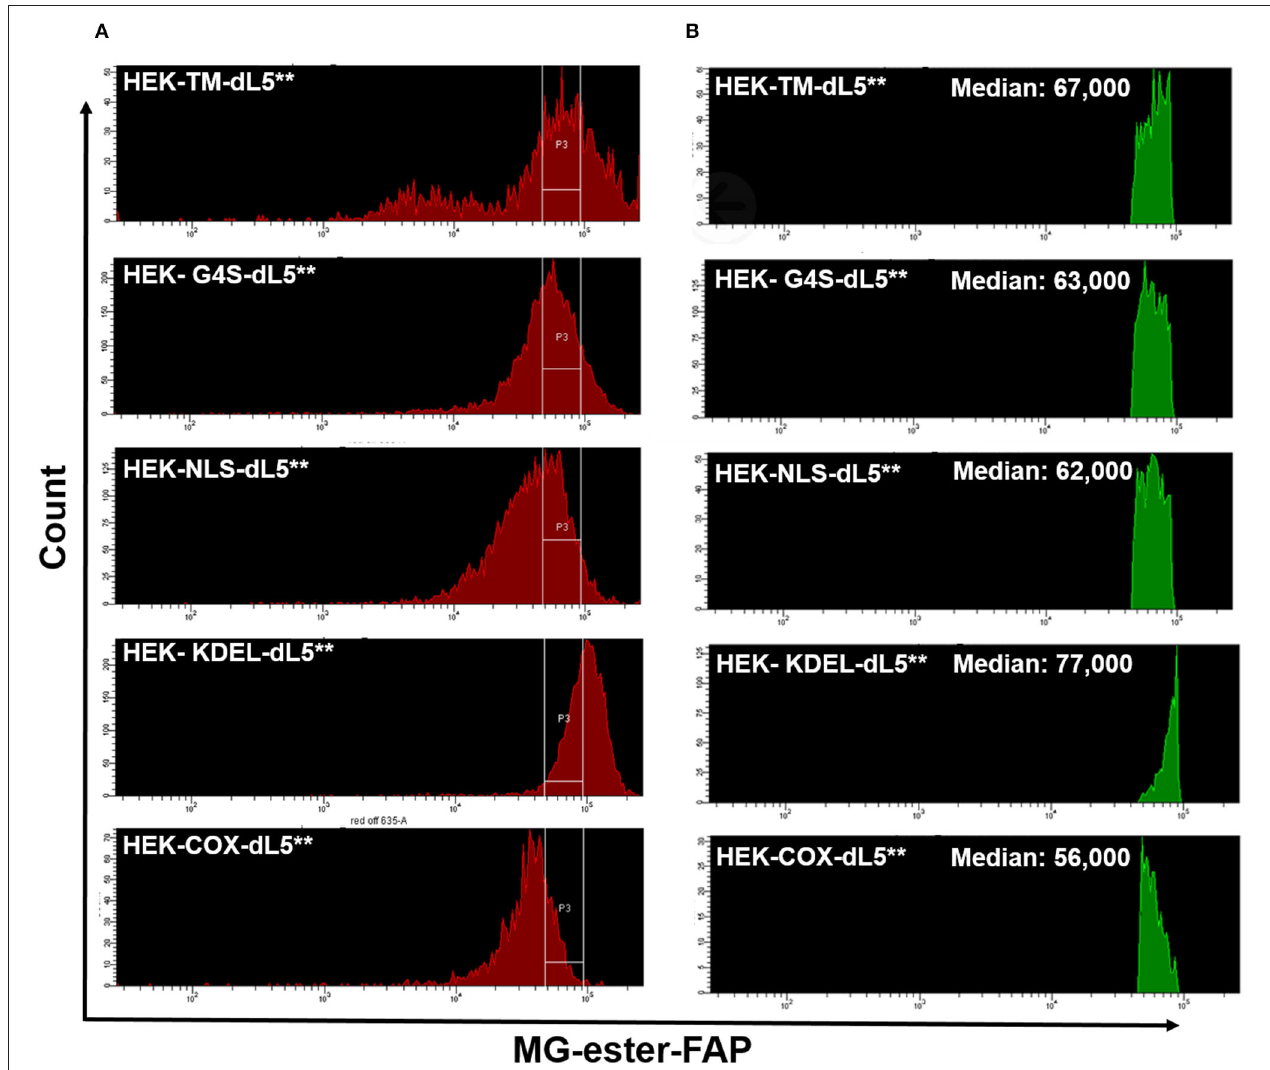
FIGURE 1 | (A) Similar expression levels of five different dL5**-expressing HEK stable cell lines prior to sorting (red, left histograms), and the consistent selection gates used to select cells of closely matched expression levels for the experiments (labeled with MG-ester). (B) The Green histograms on the right show the MG-ester fluorescence histograms of the population of cells during sorting collection that were within the collection gates P3 indicated for each cell population. The low fluorescence population in the HEK-TM-dL5** cells is a result of lifting the cells using trypsin, which strips plasma membrane protein off some of the cells. Medians of the selected populations were similar, 56,000–77,000, considerably tighter than the > 3-fold range of the unsorted median fluorescence